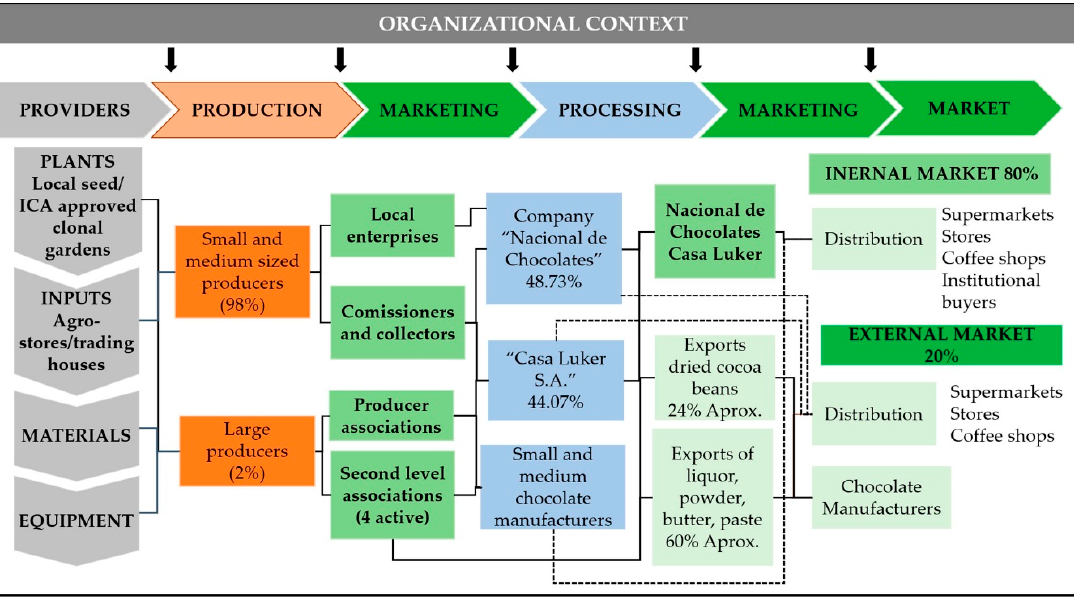
Figure 1. Main segments and organizational structure (companies under each segment) of the Colombian cocoa value chain.